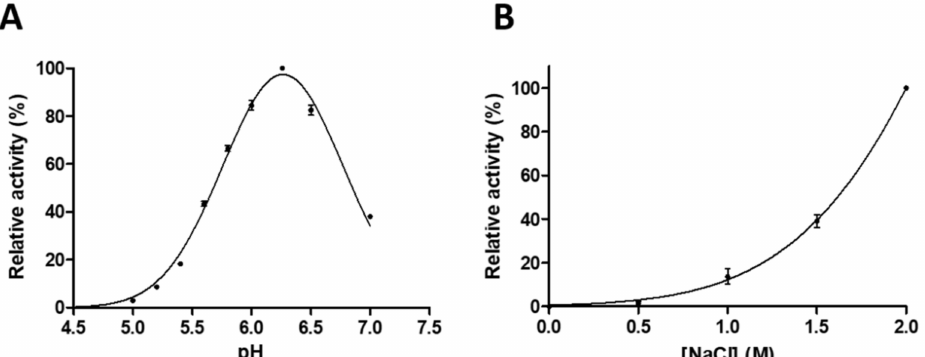
Figure 4. GST-SASP14 catalytic activity depends on pH and ionic strength. Enzyme activity was measured at increasing ( A ) pH ( n = 2) or ( B ) ionic strength ( n = 3). We used HPLC detection of substrate cleavage as described in Materials and methods. Values in parentheses represent the number of independent experiments. Error bars represent SD.